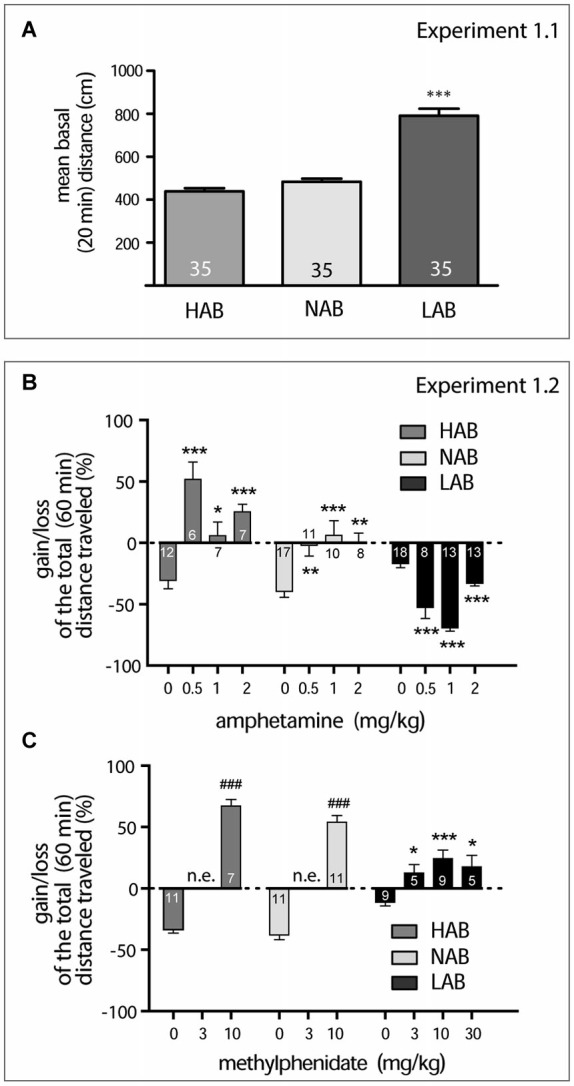
Amphetamine and methylphenidate action on locomotor activity (A). LAB mice are strictly different from NAB and HAB mice in their mean basal locomotor activity observed within 20 min in the OF (***p < 0.001). (B). Dose-dependent effect of amphetamine on locomotor activity in OF test. Here and in the next graph, data represent relative changes (gain or loss) in the mean total distance traveled within 60 min after drug administration in comparison to basal activities (last 5 min of pre-treatment 20 min period). Asterisks show the result of the Dunnett’s post hoc test comparing the effect of different doses with saline effect. (C). Dose-dependent effect of methylphenidate on locomotor activity in OF test. The two-tailed Student’s test in the cases of HAB and NAB mice revealed a difference (depicted with hash marks, ###p < 0.001) between changes in locomotor activity after saline and drug treatment. (Asterisks show the result of the Dunnett’s post hoc test comparing the effect of different doses with saline effect in LAB mice. *p < 0.05, **p < 0.01, ***p < 0.001; n.e. not examined; numbers on the graph panels represent group size.